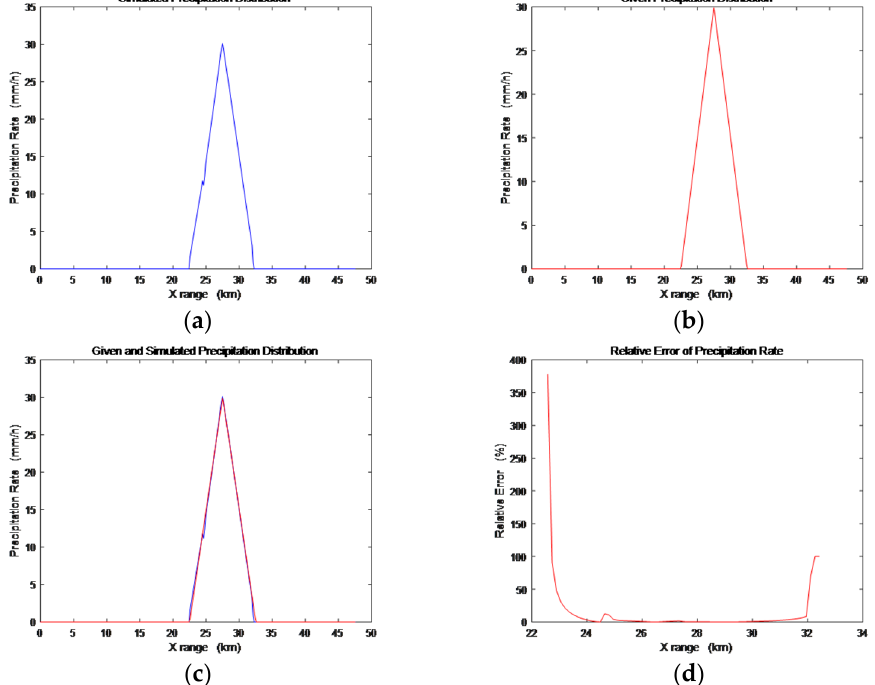
Figure 6. Triangular distribution diagrams for 𝑅(𝑥) = 30 mm/h . ( a ) Given precipitation distribu- tion; ( b ) Simulated precipitation distribution; ( c ) Given precipitation distribution and simulated pre- cipitation distribution; ( d ) Relative error between given and simulated results.